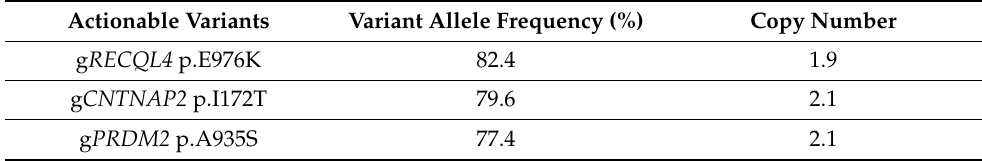
Table 1. Actionable variants detected by whole-exome sequencing.